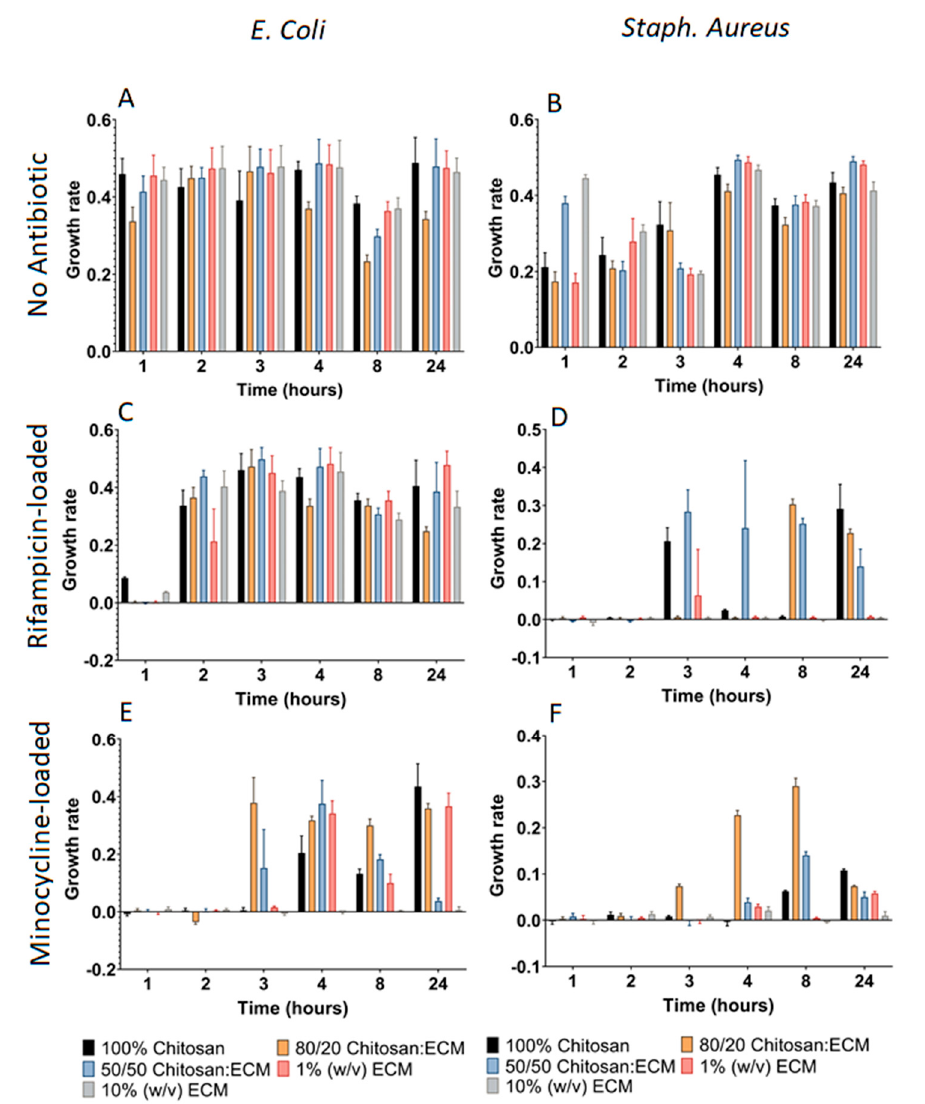
Figure 4. Graphs showing the calculated growth rate of E. Coli ( A , C , E ) and Staph. Aureus ( B , D , F ) bacteria exposed to different scaffold formulation supernatants. ( A , B ) growth rate of E. Coli ( A ) and Staph. Aureus bacteria when exposed to supernatant samples from scaffold formulations without antibiotics; ( C , D ) growth rate of E. Coli ( C ) and Staph. Aureus ( D ) when exposed to supernatant samples of rifampicin-loaded scaffold formulations; ( E , F ) growth rate of E. Coli ( E ) and Staph. Aureus ( F ) when exposed to supernatant samples of minocycline-loaded scaffold formulations.